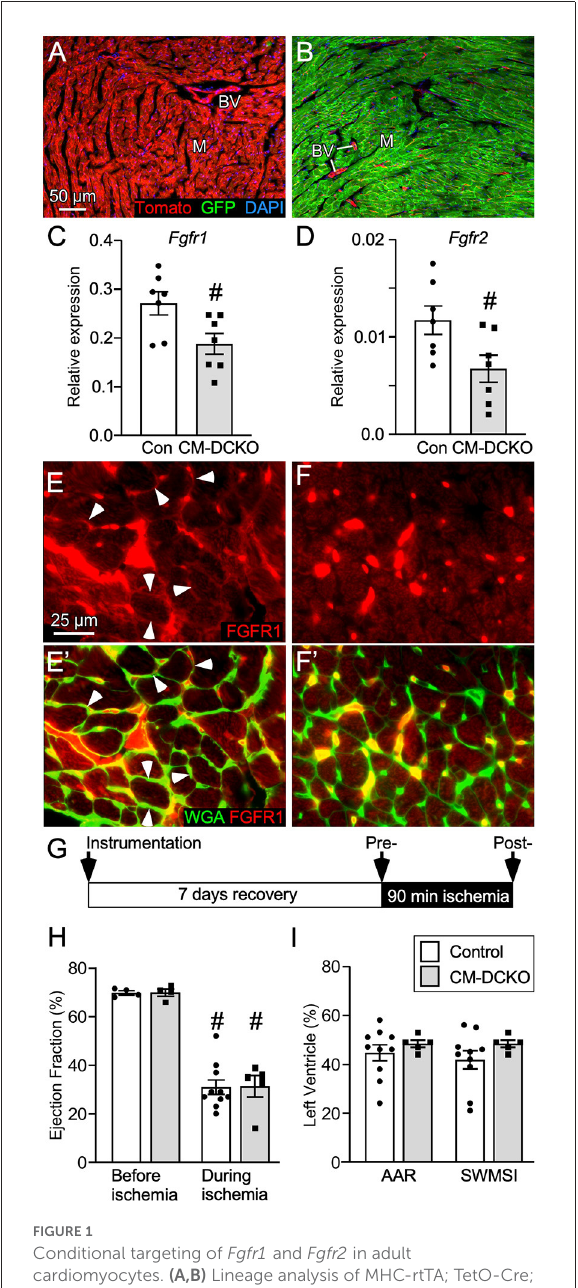
FIGURE1 Conditional targeting of Fgfr1 and Fgfr2 in adult cardiomyocytes. (A,B) Lineage analysis of MHC-rtTA; TetO-Cre; ROSA mTmG mice. (A) In the absence of DOX all cells within the heart express Tomato (red). (B) Mice fed DOX chow for 4 weeks beginning at P21 express Cre in myocytes and show recombination in most myocytes (M) which replaces Tomato (red) with GFP (green). Note that blood vessels (BV), endothelial cells, and a few myocytes are still red. DAPI (blue). (C,D) Quantitative RT-PCR (TaqMan ® ) of the whole left ventricle from CM-DCKO and DFF control (Con) mice fed DOX chow for 4 weeks showing reduced expression of Fgfr1 (C) and Fgfr2 (D) in CM-DCKO hearts compared to control hearts. # P < 0.05 vs control mice. (E,F) In control hearts (E,E’) , immunostaining for FGFR1 (red) shows expression on myocyte membranes (arrowheads) by co-localization with WGA (FITC, green). In CM-DCKO hearts (F, F’) , no membrane FGFR1 expression